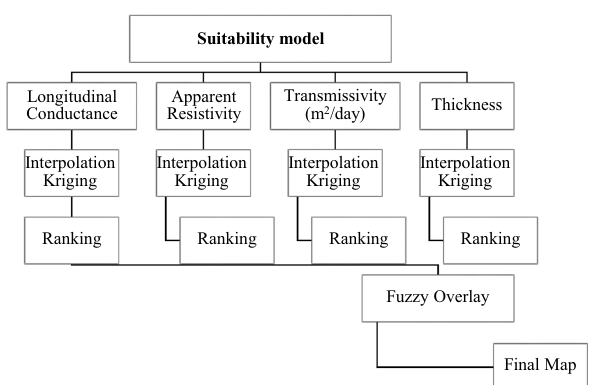
Fig. 3 The suitability model flowchart